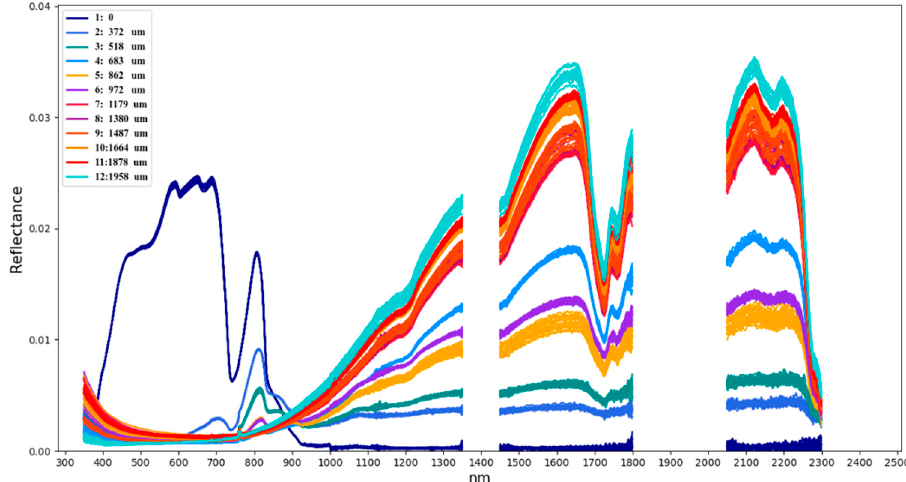
Figure 3. Remote sensing reflectances of each experimental group.